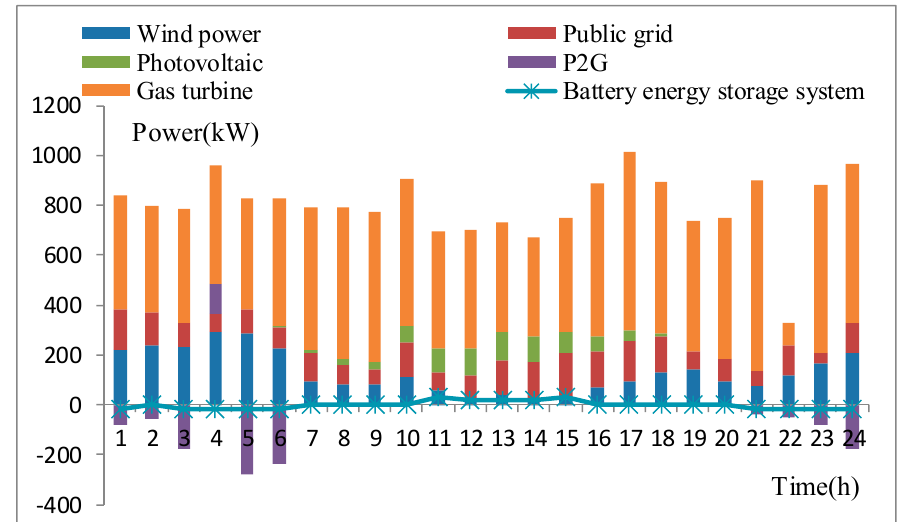
Figure 5. The output structure of each device in Scenario 3.